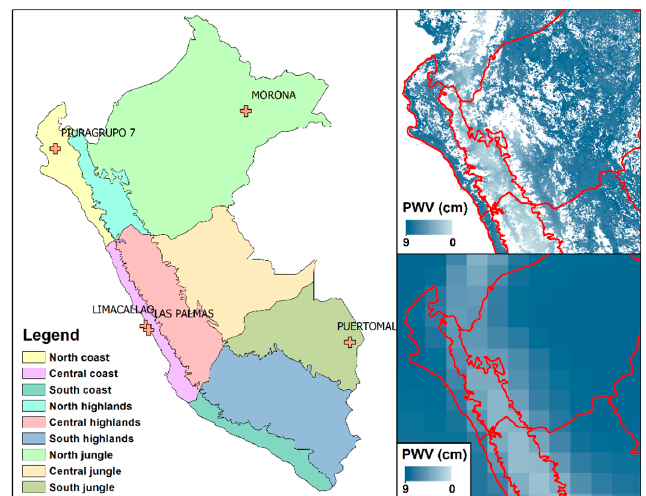
Figure 1. Left: Map of Peru representing the sub regions analyzed in this study: north coast, central coast, south coast, north highlands, central highlands, south highlands, north jungle, central jungle and south jungle. Cross symbols refer to the locations of radiosonde stations described in Table 1. Right: Monthly PWV (arbitrary selection for February-2017) over a Peruvian area obtained from MODIS products at 1 km spatial resolution (top), and from ERA-Interim products at 0.75 ◦ spatial resolution (79 km approx.) (bottom).